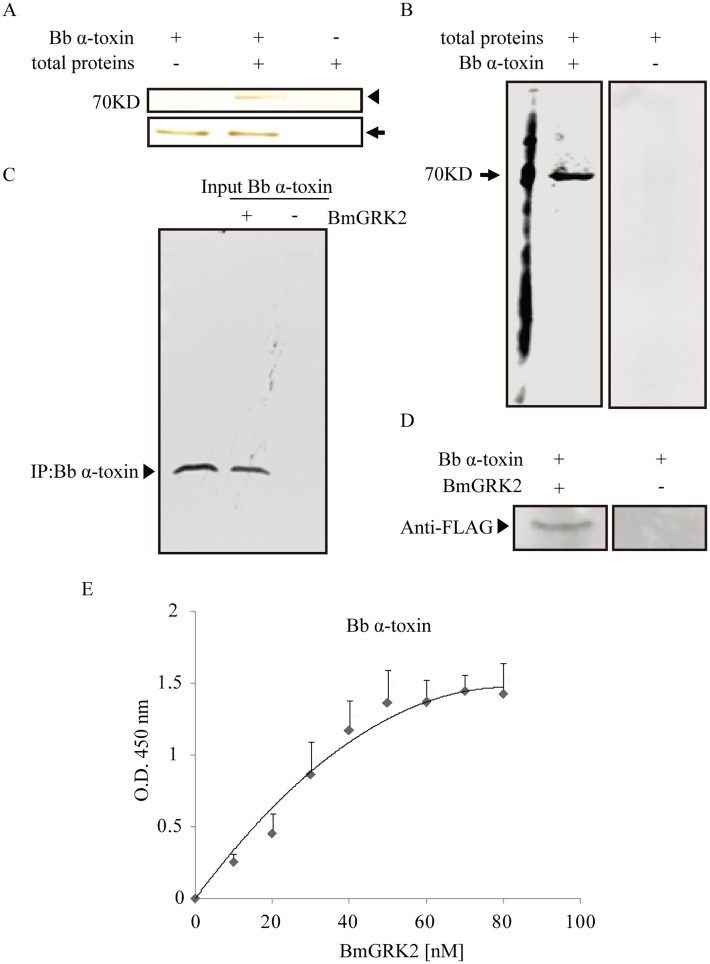
Interaction analysis of Bb α-toxin protein with BmGRK2.(A) His-tag pull-down assays of Bb α-toxin with total proteins, extracted from midguts BBMV of 5th-instar larvae. Lane 1, Bb α-toxin protein incubated with PBS as control. Lane 2, Bb α-toxin protein incubated with total proteins. Lane 3, NTA beads incubated with total proteins as control to exclude the possibility of any proteins directly interacting with the NTA resin. Arrowhead indicates the pull-down protein of a molecular mass of ~70kDa (lane 2) that bounds with Bb α-toxin protein, and arrows indicate the Bb α-toxin. (B) Far-western blot of Bb α-toxin and total proteins. Total proteins were separated by using 12% (wt/vol) SDS-PAGE and transferred to PVDF membranes. The membranes were either used directly immunoblots using His-tag antibody (lane 1) or used for far-western blot analysis with Bb α-toxin protein incubated before adding His-tag antibody (lane 2). Positive bands were observed only at a molecular mass of 70kDa. (C) Co-IP of Bb α-toxin and BmGRK2 proteins with Flag tag. Lane 1 shows that Bb α-toxin protein was directly immunoblots using the His-tag antibody as a positive control. Lane 2 shows that BmGRK2-Flag protein incubated with the anti-Flag antibody bound to protein G magnetic beads using the BS3 for crosslinking and incubated with the Bb α-toxin protein. Lane 3 shows that the anti-Flag antibody bound to protein G magnetic beads incubated with Bb α-toxin as negative control. Positive bands were observed only when Bb α-toxin/BmGRK2 complexes were present. (D) Far-western blot of BmGRK2 and Bb α-toxin proteins. Bb α-toxin protein as in (B) but with anti-Flag antibody (lane 2) or incubation with BmGRK2 before anti-Flag (lane 1). The arrowhead indicated that BmGRK2 was present. (E) ELISA saturation binding assays of Bb α-toxin protein to BmGRK2.